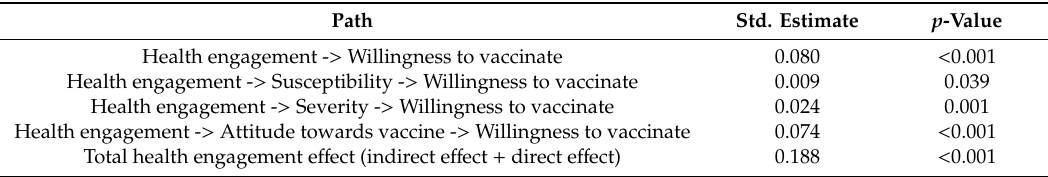
Table 3. Direct, indirect, and total e ff ect of health engagement on willingness to